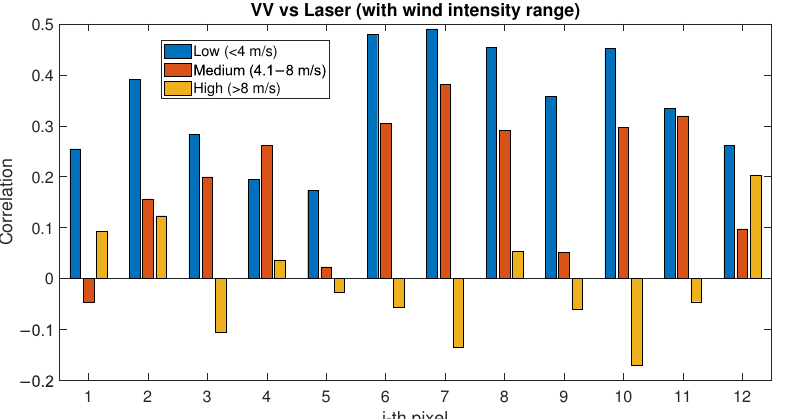
Figure 9. Correlation factor between PLS intensity and SAR (VV polarisation) backscatter evaluated for low-, medium- and high-wind-speed